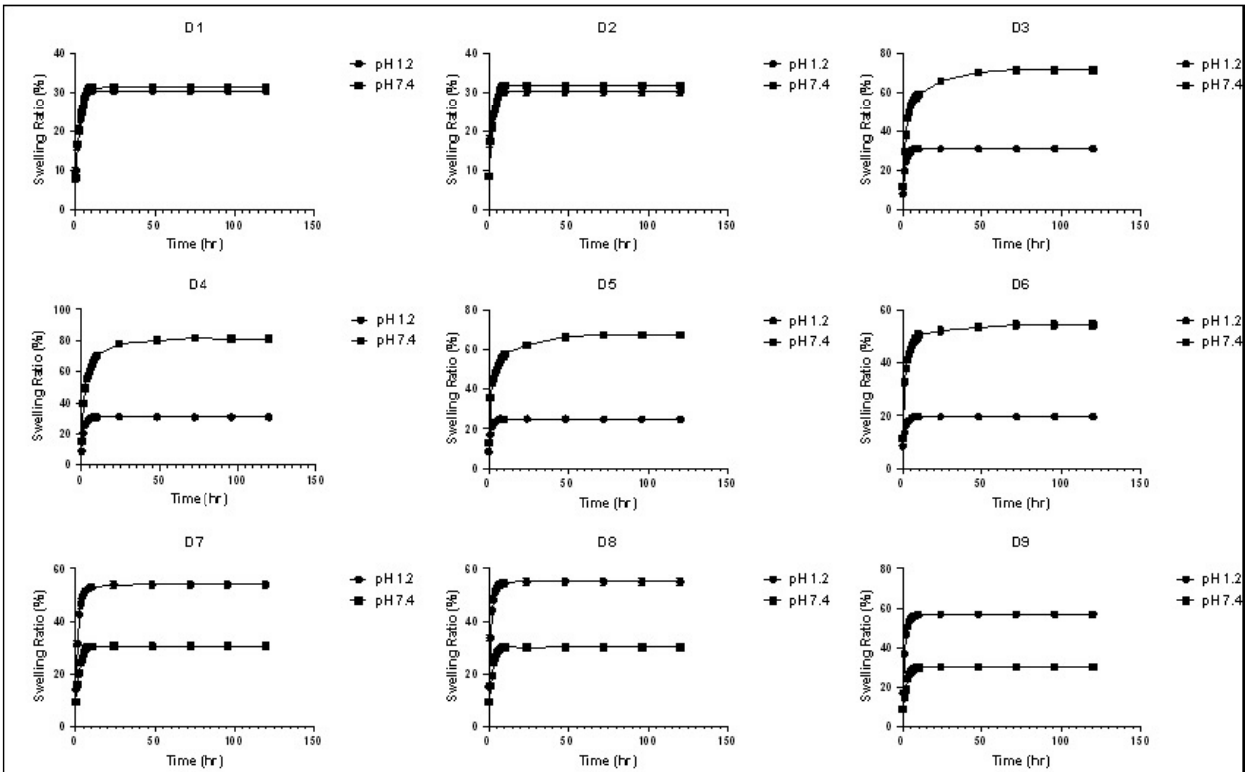
Figure 1. The swelling profiles of the polymeric formulations (mean ± SD, n = 3) at pH 1.2 and pH 7.4.